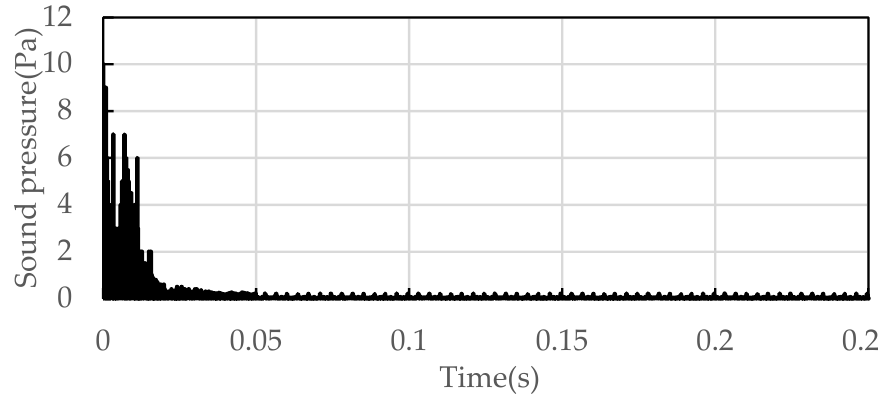
Figure 9. The graph of sound pressure varying with time at receiving points. In order to verify the accuracy of the grid model, the first boundary layer at 0.005 mm, 0.01 mm, and 0.02 mm is selected for the grid sensitivity analysis, as shown in Figure 10.